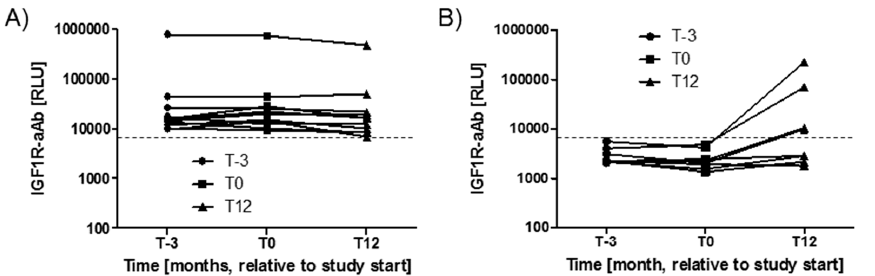
Figure 2. Variations in IGF1R-Ab concentrations with time. The serum samples drawn from the study participants covered a time period of 15 months (enrolment, T-3; study start, T0; and study end, T12). ( A ) The majority of positive samples remained positive during the full study period, indicating stable IGF1R-aAb concentrations over time. ( B ) Four samples developed natural IGF1R-aAb de novo during the study. The signal strengths of these samples are shown in comparison to four constantly negative samples. The threshold for positive IGF1R-aAb is indicated by the thin broken